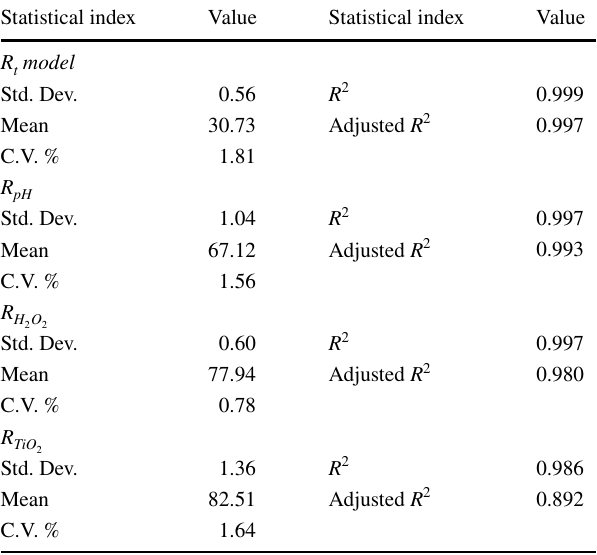
Table 7 Fit statistics for the developed RSM